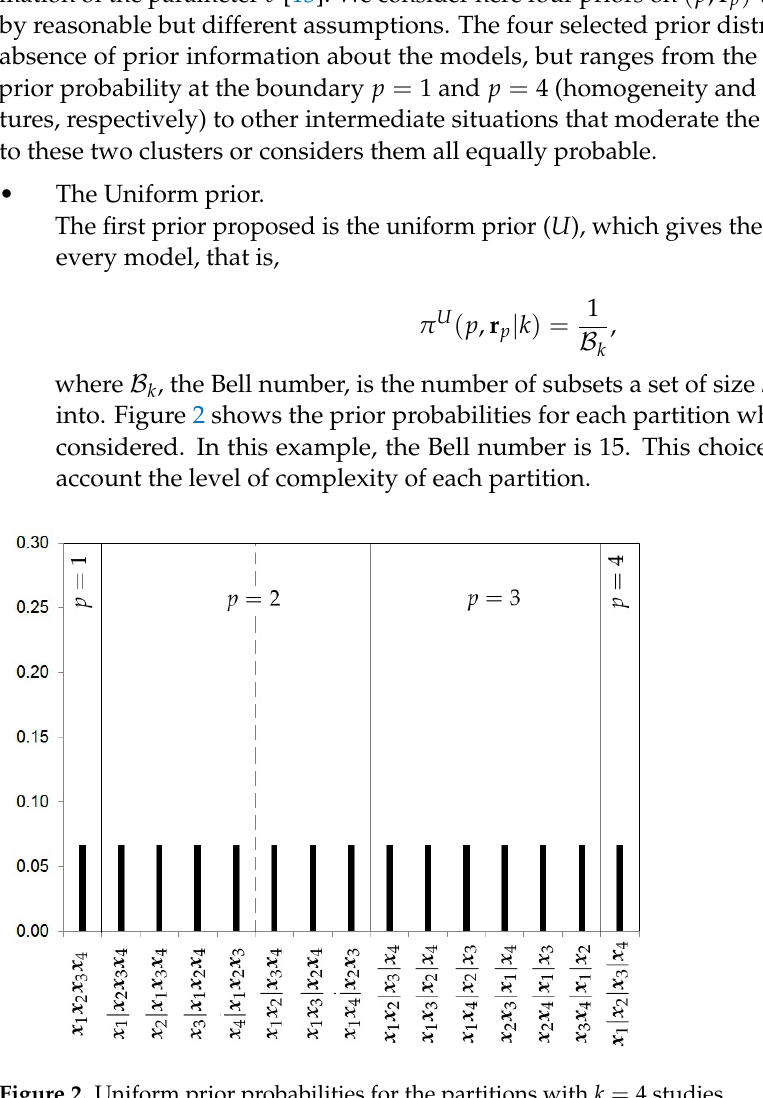
Figure 2. Uniform prior probabilities for the partitions with k = 4